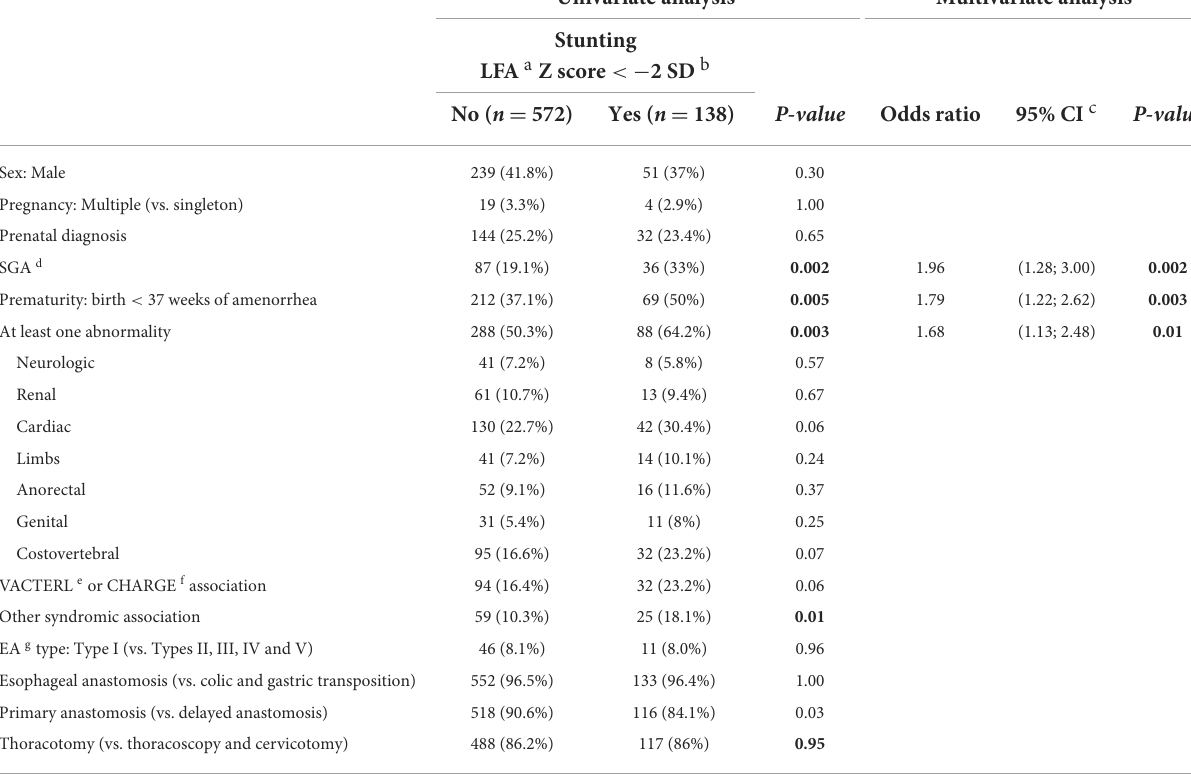
Univariate analysis Multivariate